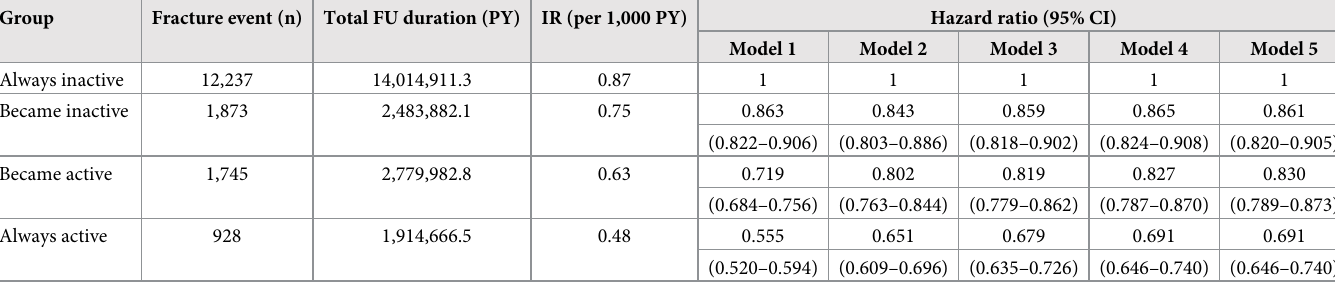
Table 3. Hazard ratios for hip fracture according to change in regular physical activity in adults aged � 40 years. Group Fracture event (n) Total FU duration (PY) IR (per 1,000